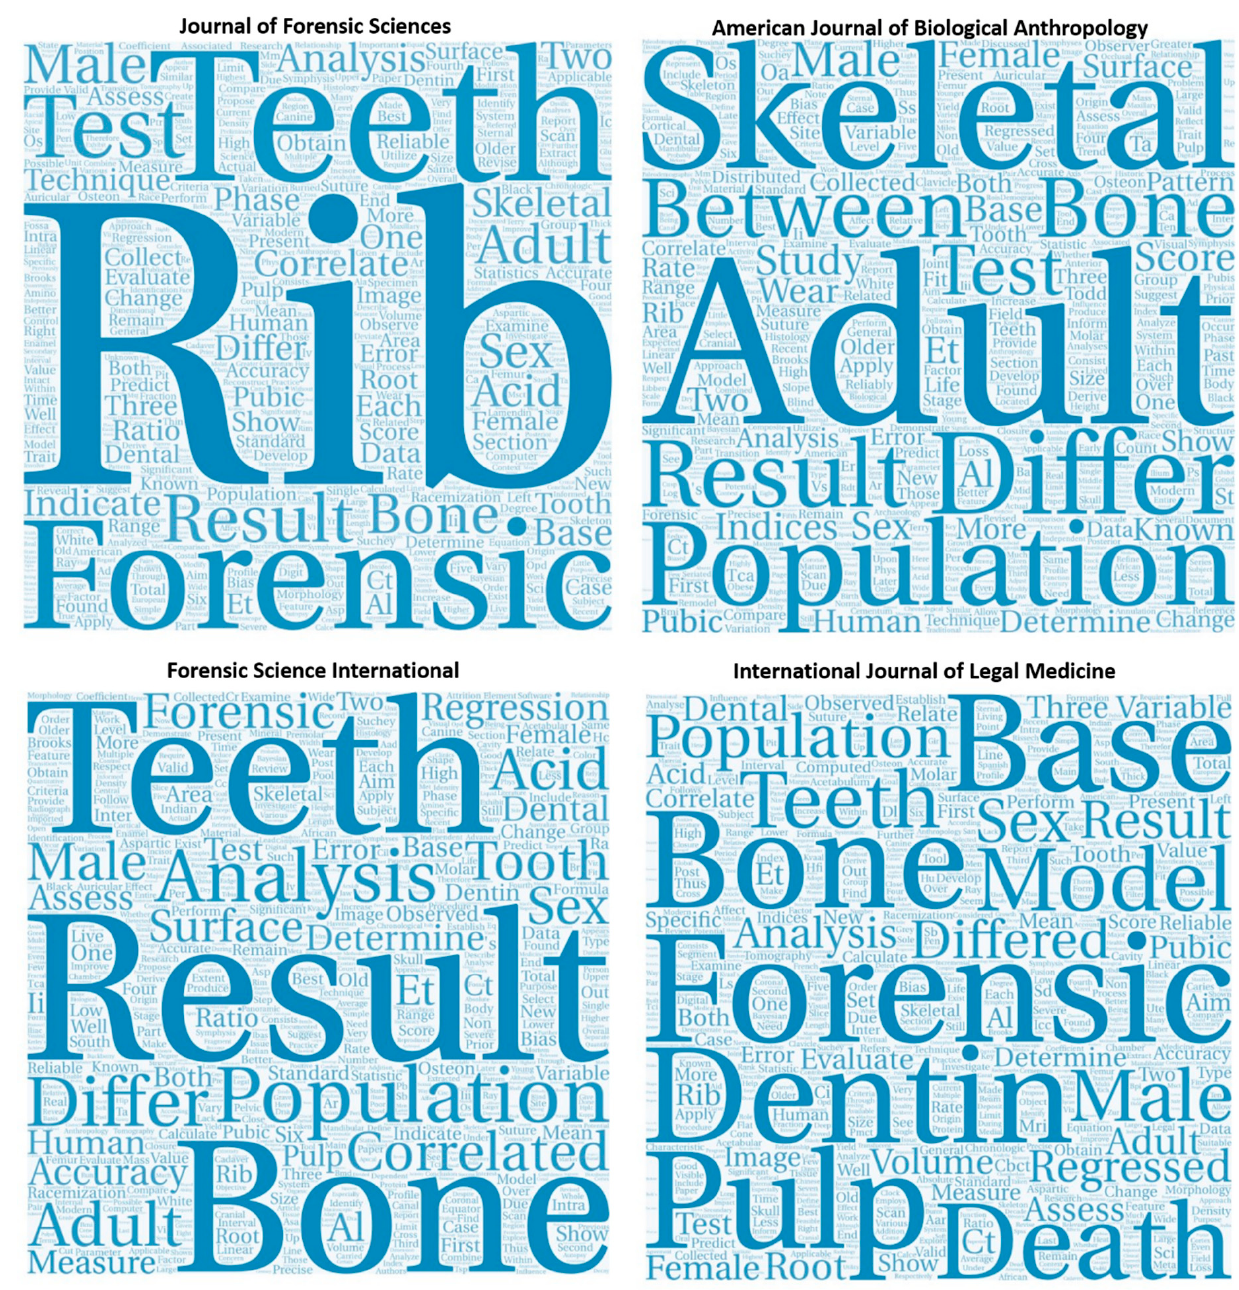
Figure 10. Word Clouds for frequent terms used in title and abstracts for the TOP4 journals.